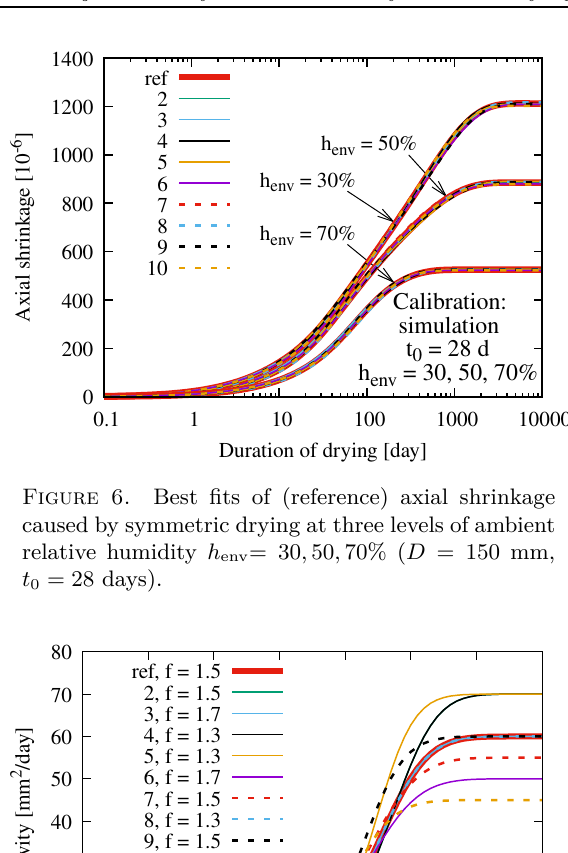
9, f = 1.5 10, f = 1.7